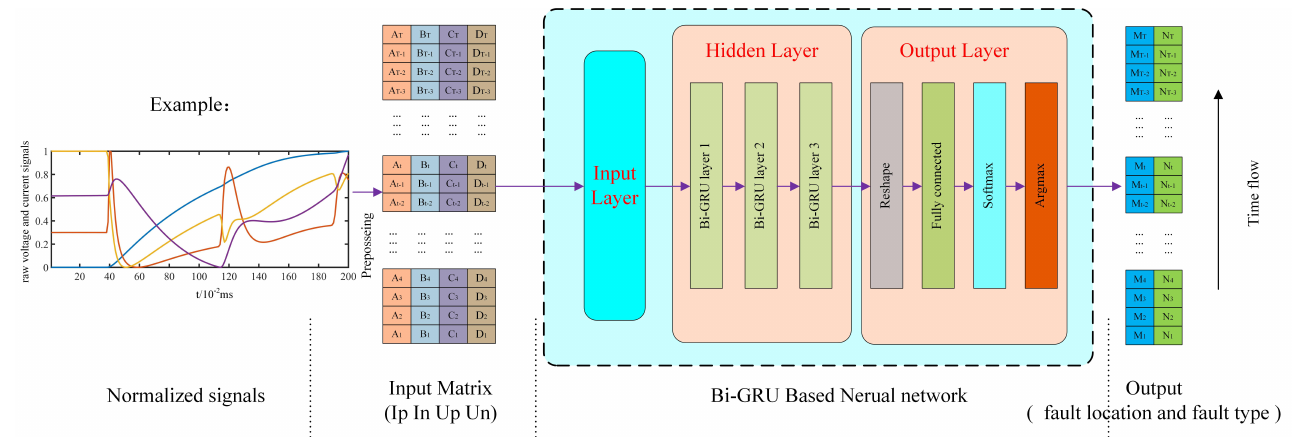
Figure 9. The overall architecture of the proposed end-to-end